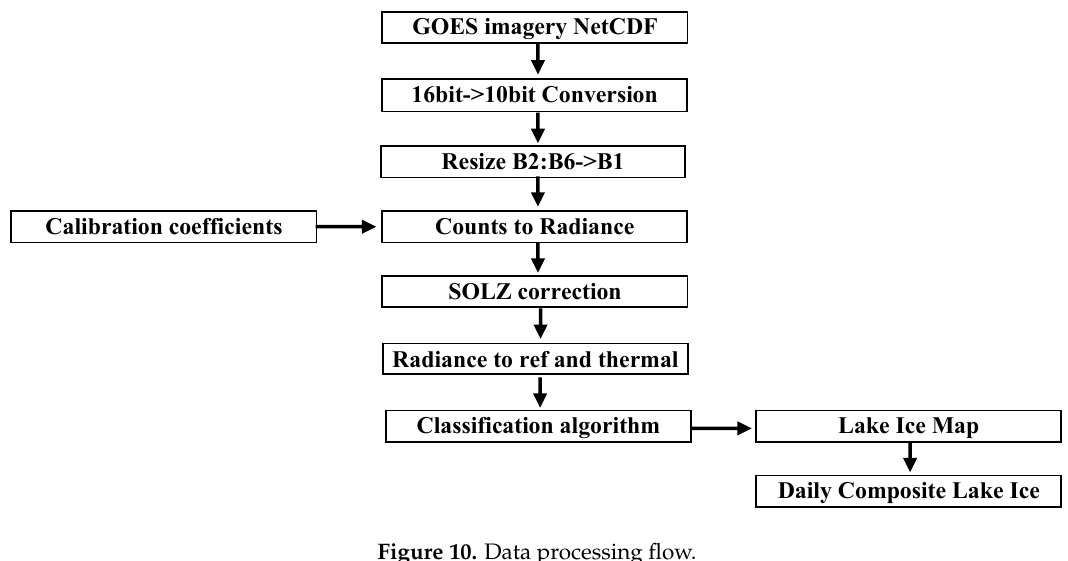
Figure 10. Data processing flow.